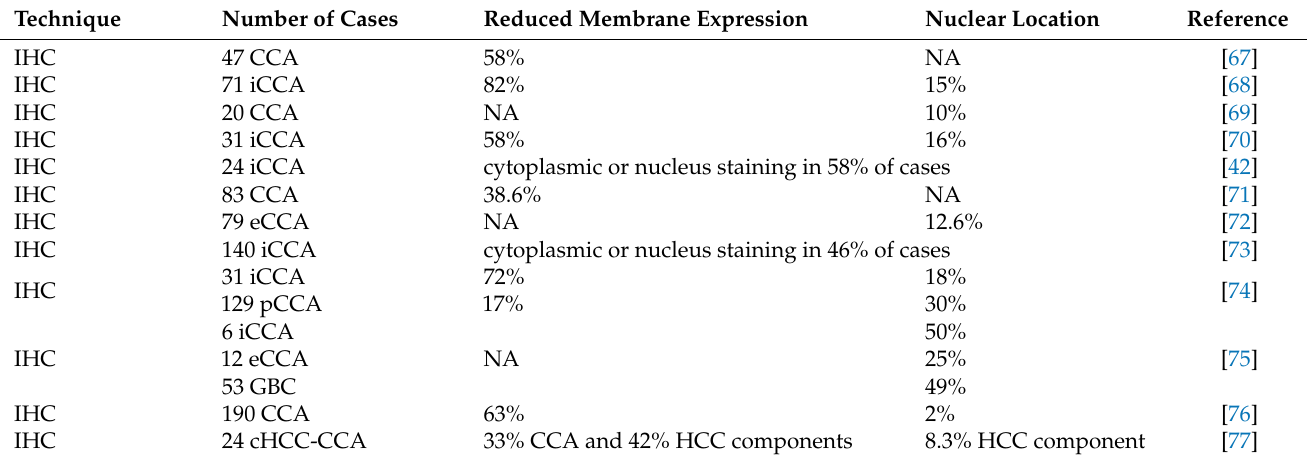
Table 2. Altered expression of β -catenin in